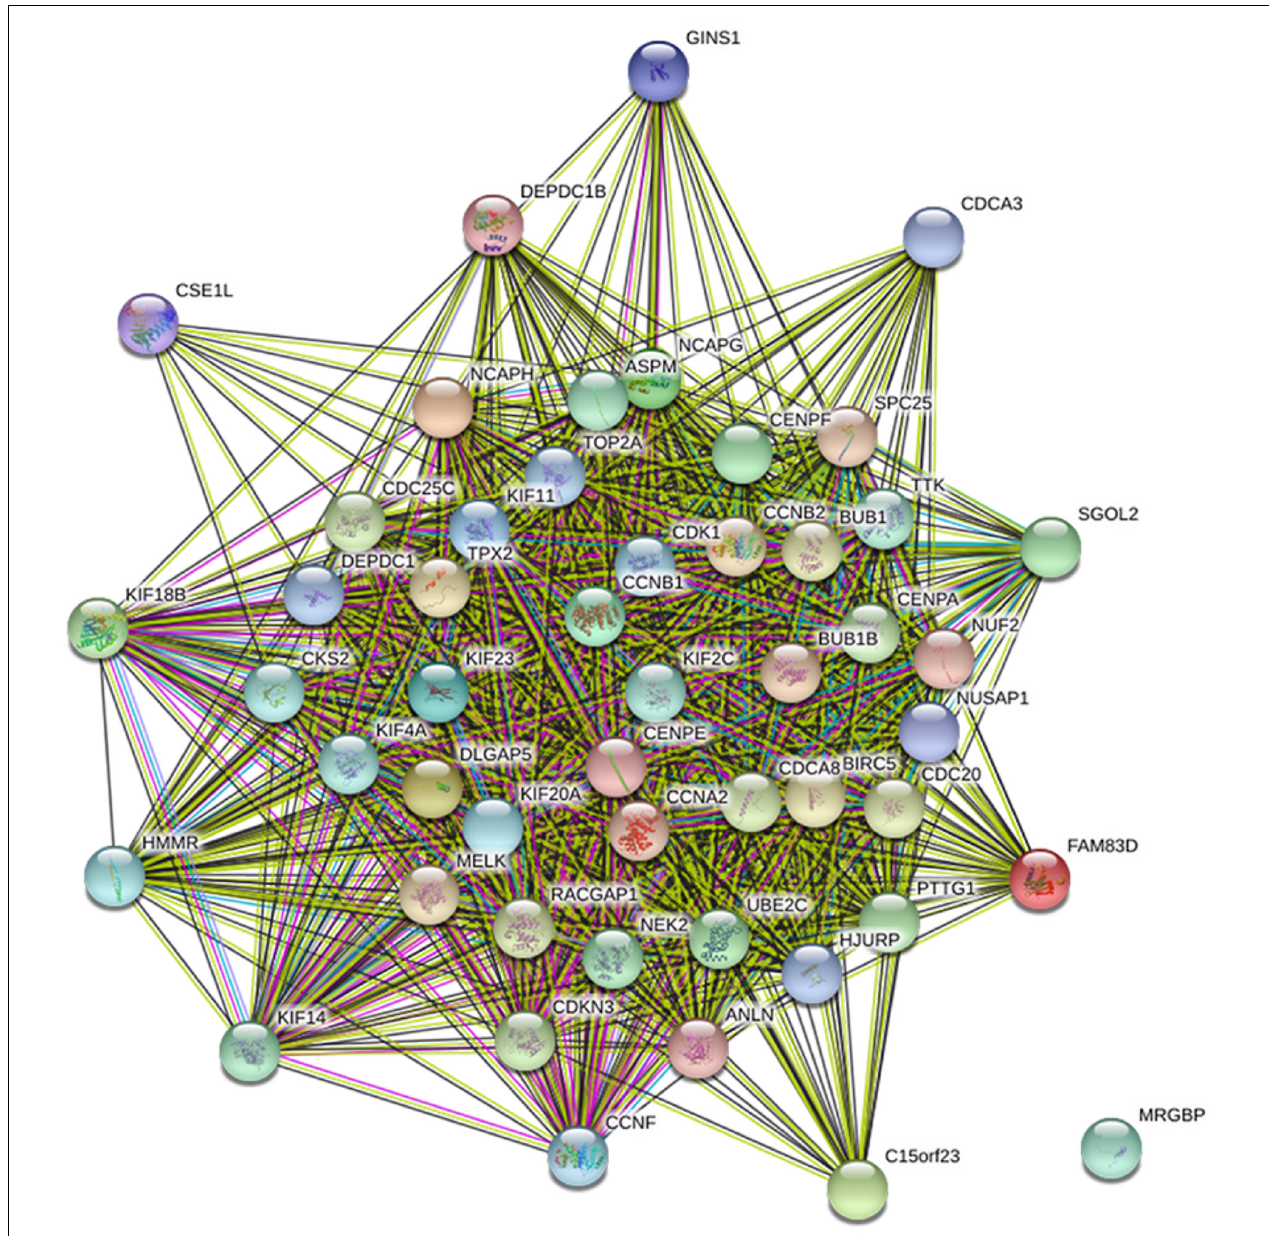
FIGURE 1 | The protein interaction network of genes co-expressed with AURKA. Blue line: from curated databases; Purple line, experimentally determined; Green line, gene neighborhood; Yellow line, text